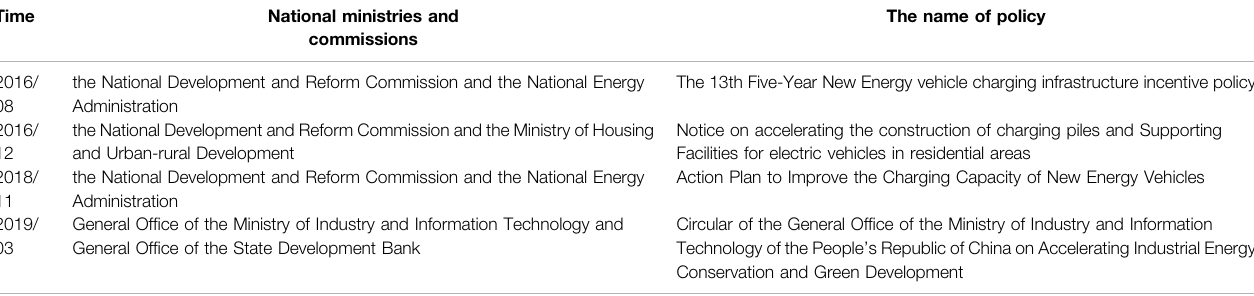
TABLE 1 | Policies relating to new-energy vehicles and charging piles.